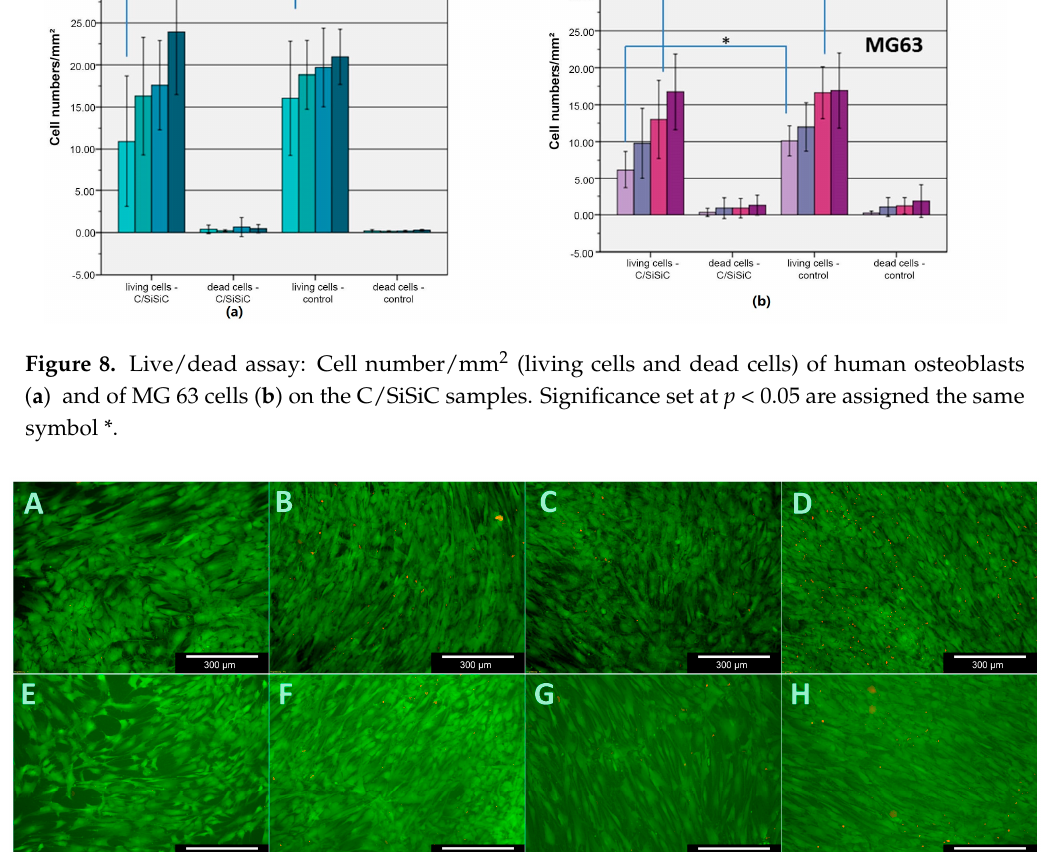
Figure 9. Viability assay with human osteoblasts for 21 days. ( A – D ): samples (days 3, 7, 14 and 21); ( E – H ): controls (days 3, 7, 14 and 21).